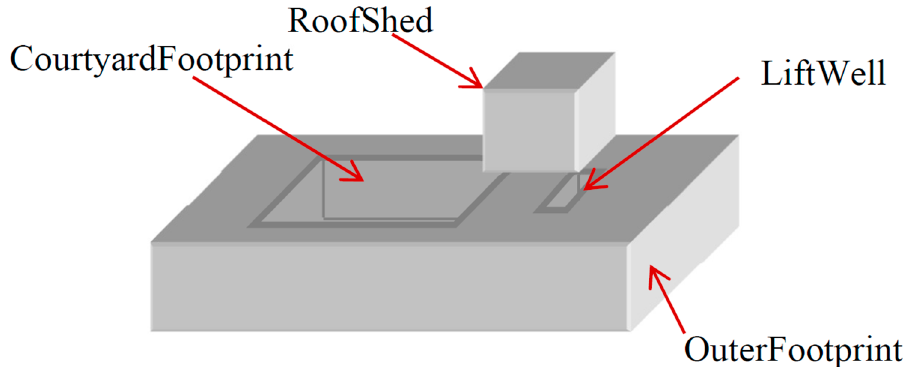
Figure 12. Note that the roof shed overlaps and partially blocks the CourtyardFootprint and LiftWell.